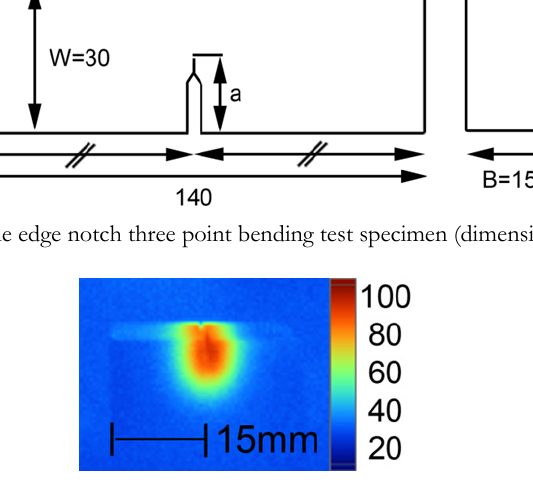
Figure 3: Thermal image of a heated notch with a copper sheet at 90ºC (temperature scale in